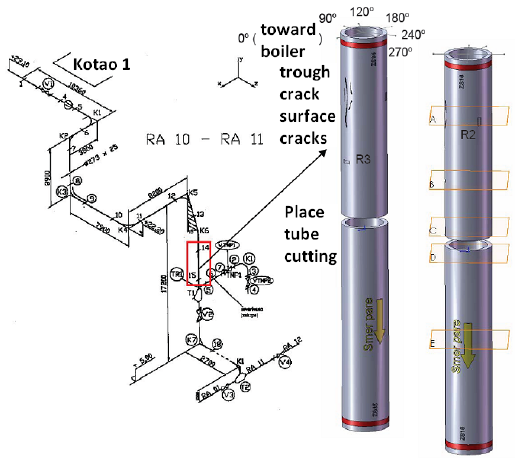
Figure 6: Scheme of measurement tests (dimensional inspection of the damaged steam line part).